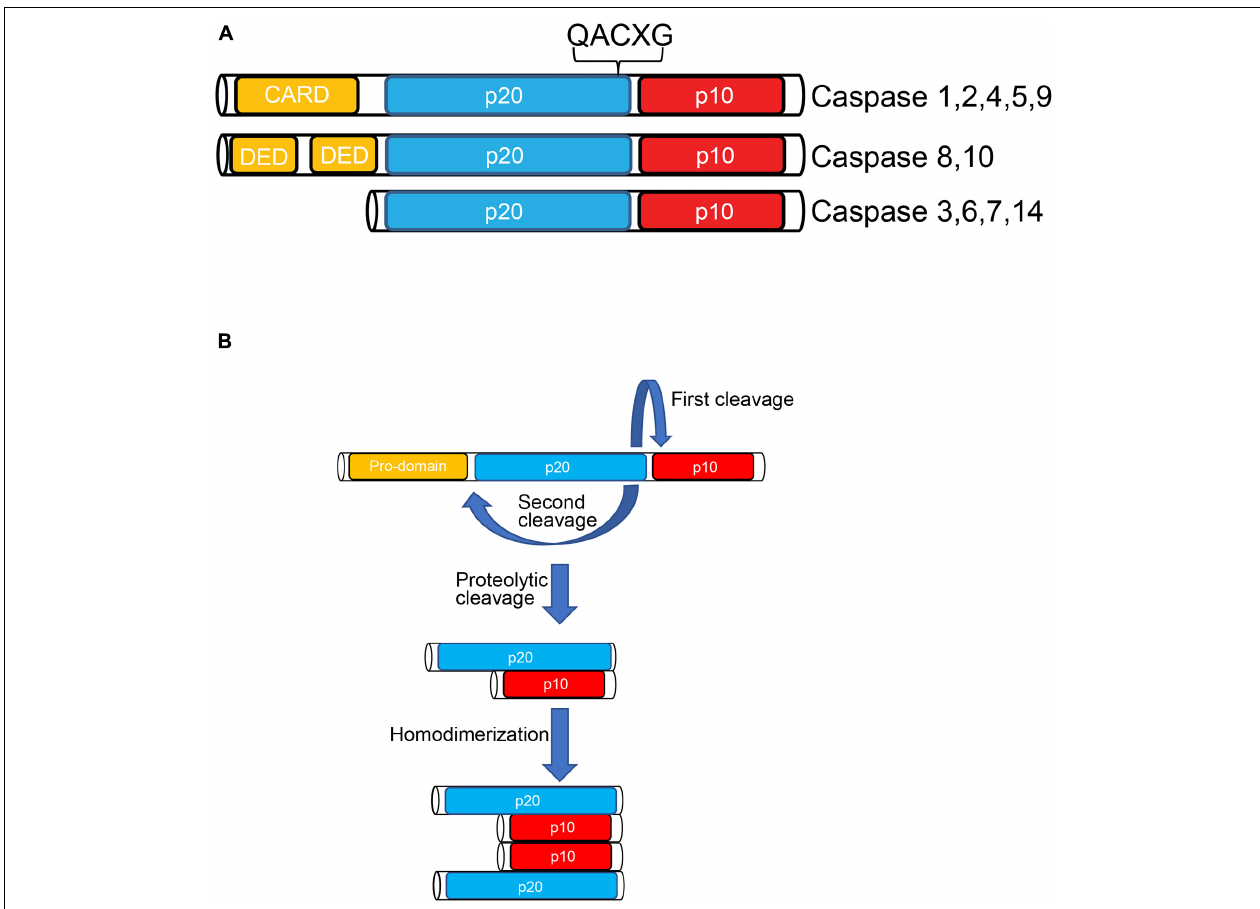
FIGURE 1 | The caspase family of proteases. (A) Members of the caspase family, are synthesized as inactive precursors called zymogens composed of a prodomain, a p20 large subunit and a p10 small subunit. The p20 subunit contains the active site of the enzyme harboring a “QACXG” pentapeptide motif. Initiator Caspases are characterized by the presence of a long N-terminal prodomain whereas the N-terminus domain of effector caspases is shorter. (B) Caspase activation is achieved by proteolytic cleavage between the large and small subunits and removal of the N-terminus prodomain. This post translational modification leads to new conformational state in which caspase homodimers are fully